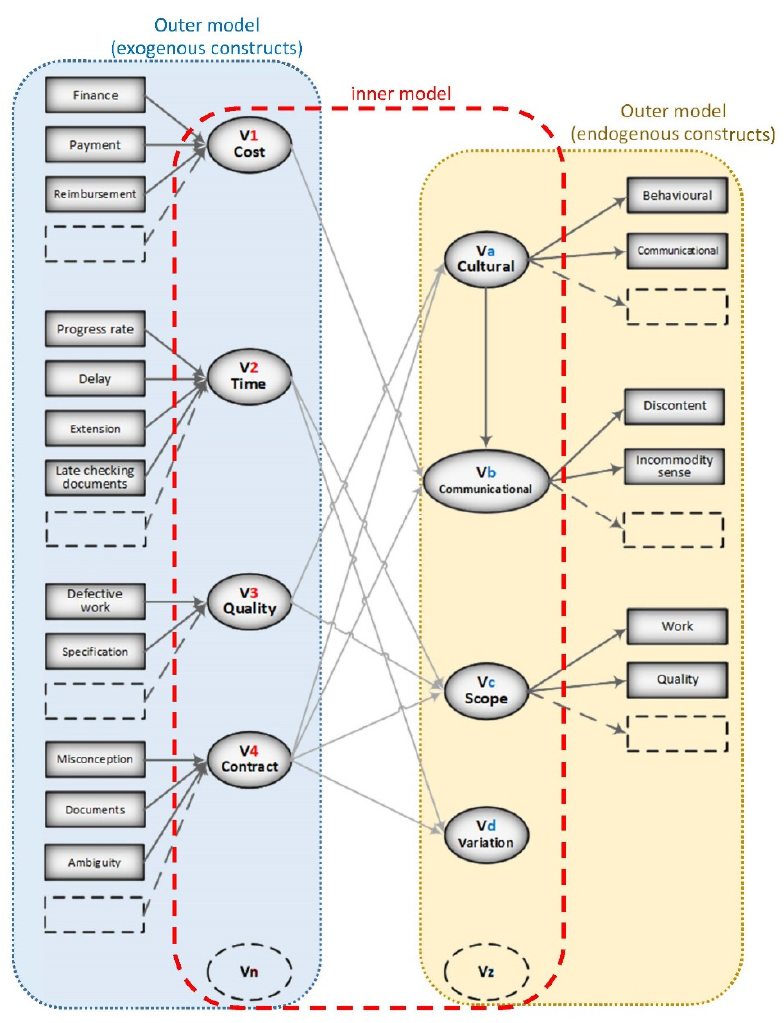
Figure 3. A path model section for PLS-SEM.